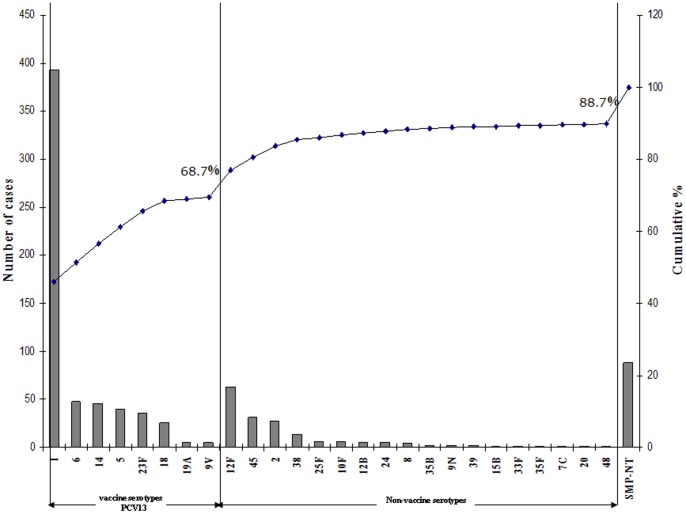
Bar chart showing rank order and cumulative serotype distribution (%) for PCV13 (left) and non PCV13 (right) serotypes.